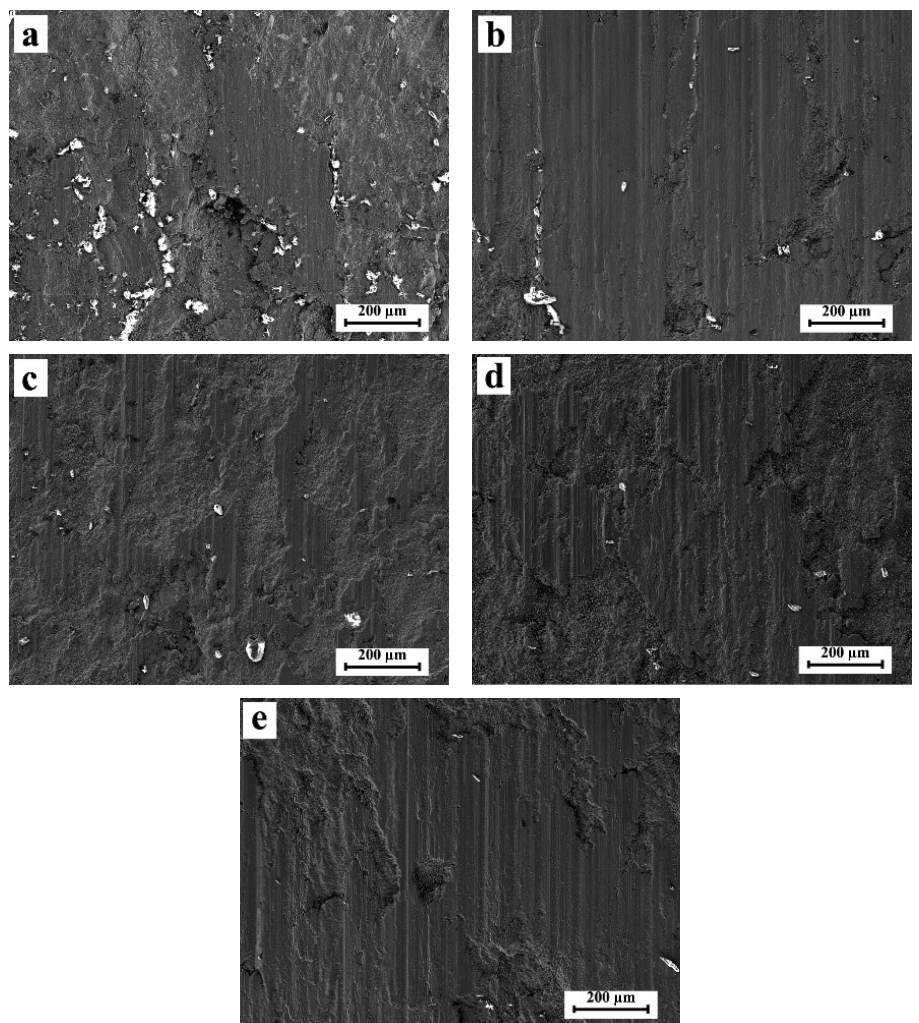
Figure 6: SEM images of worn surfaces of composite materials with different amounts of Al 2 O 3 reinforcement under 30 N loads; Al+2Gr (a), 3% Al 2 O 3 (b), 6% Al 2 O 3 (c), 9% Al 2 O 3 (d) and 12% Al 2 O 3